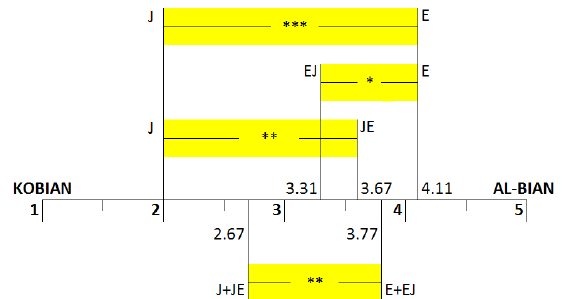
Figure 4. Significant difference in preference, on a scale from 1 to 5, between KOBIANandAL-BIANamongthedifferentgroupsJ,E,EJandJE(de- scribedinsection3.1), andbetweenthetotaloftheJapanese(J + JE) against the total of the Egyptians (E + EJ). In yellow, statistically sig- nificant differences (one asterisk (*) means p <.05; two asterisks (**) mean p <.01; three asterisks mean p <.001).